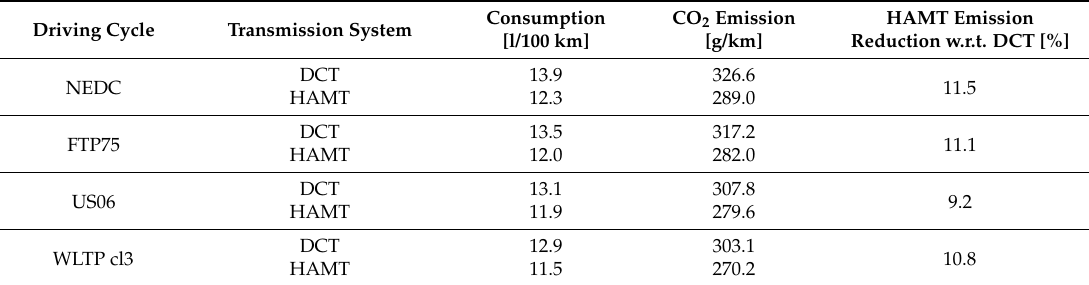
Table 3. Simulation results for the NEDC, FTP75, US06, and WLTP (cl 3) driving schedules. Driving